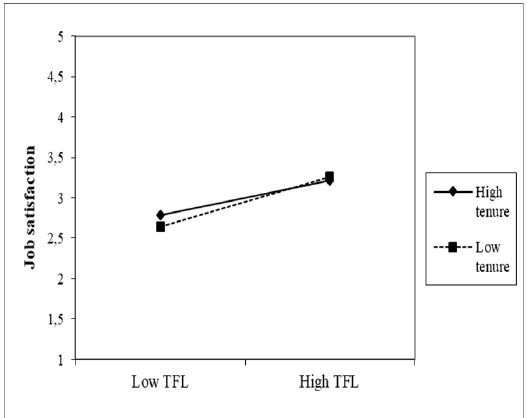
Figure 2. Moderating effect of management practice FLNMs on the CS–JS relationship.